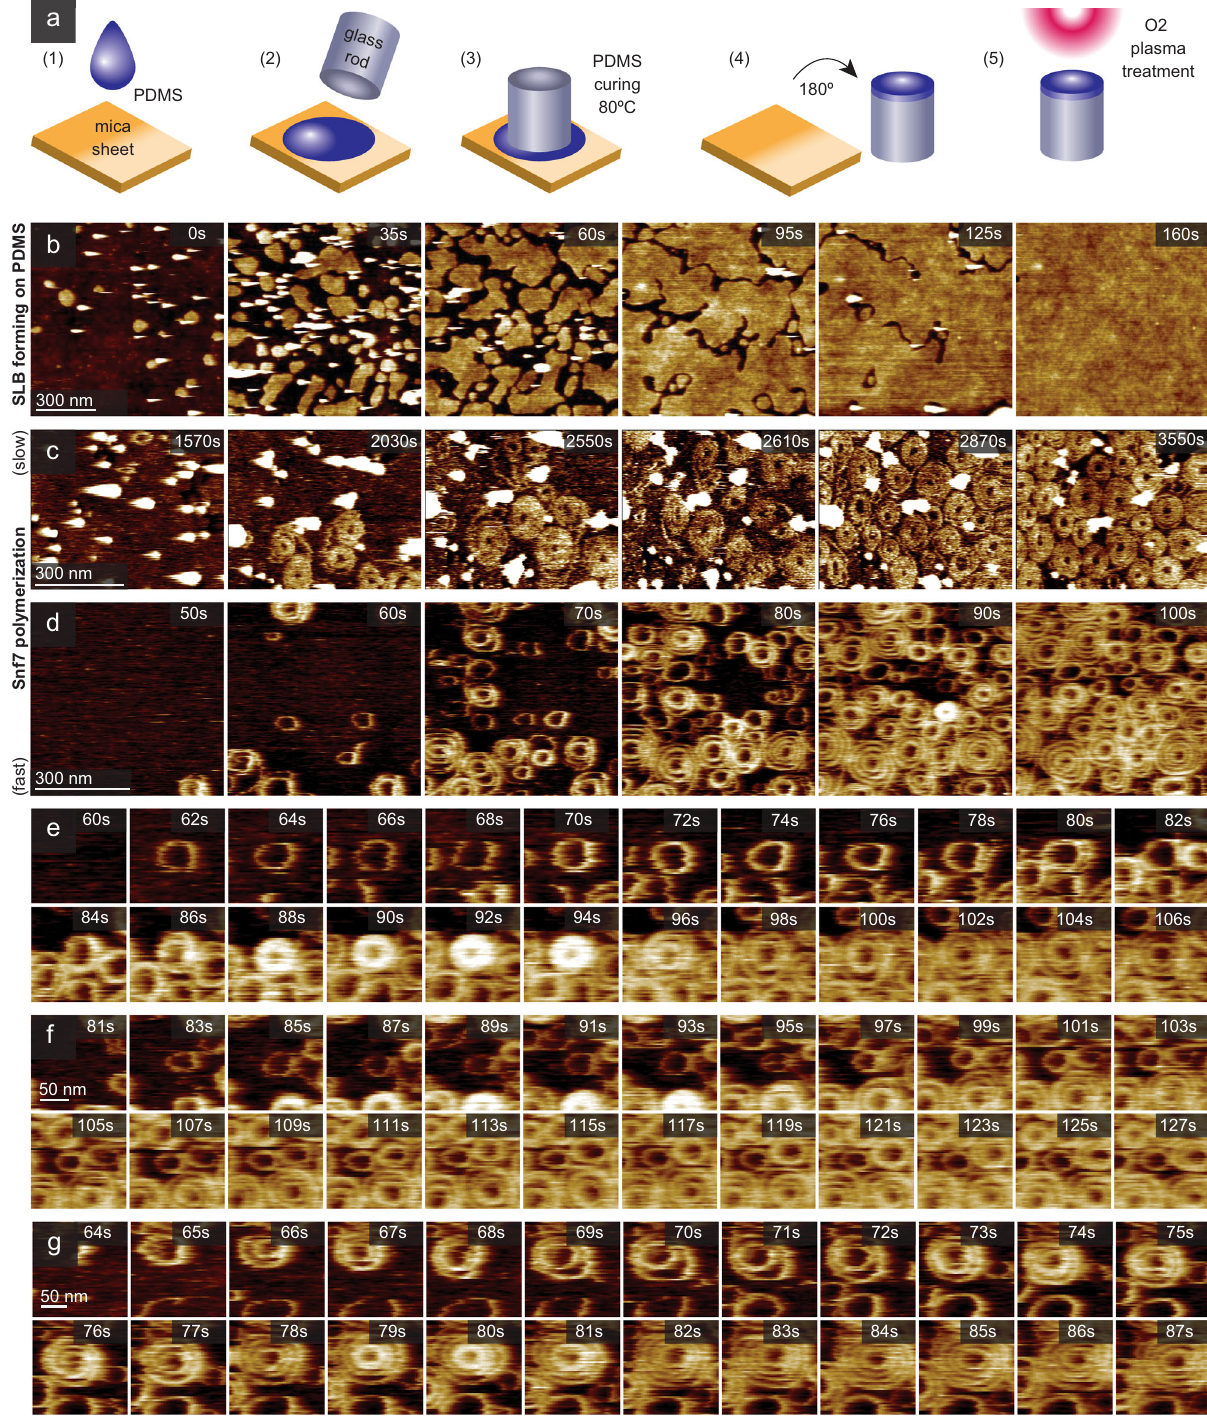
Fig. 6 PDMS sample support design, SLB formation and Snf7 spirals on a soft surface. a Preparation of a soft PDMS sample support for HS-AFM. (1) A PDMS drop is pipetted onto atomically fl at mica. (2) The HS-AFM sample stage is deposited on the PDMS droplet. (3) PDMS curing. (4) HS-AFM sample stage with PDMS layer is separated from mica sheet. (5) PDMS surface is O 2 -plasma treated to enhance hydrophilicity. The PDMS had a Young ’ s modulus of ~270kPa (Supplementary Fig. 4). b SLB formation through SUV spreading and fusion (Supplementary Movie 8). c HS-AFM images of slow Snf7 polymerization on a PDMS-SLB (Supplementary Movie 9). d HS-AFM images of rapid Snf7 spiral polymerization on a PDMS-SLB (Supplementary Movie 10). HS-AFM time-lapse of a Snf7 spiral ( e ) polymerizing into a spiral of increased protrusion height, followed by a collapse into plane and spiral growth, ( f ) forming a closed stunted Snf7 ring unable of further growth, and ( g ) polymerizing into a large spiral displaying dynamics of the innermost